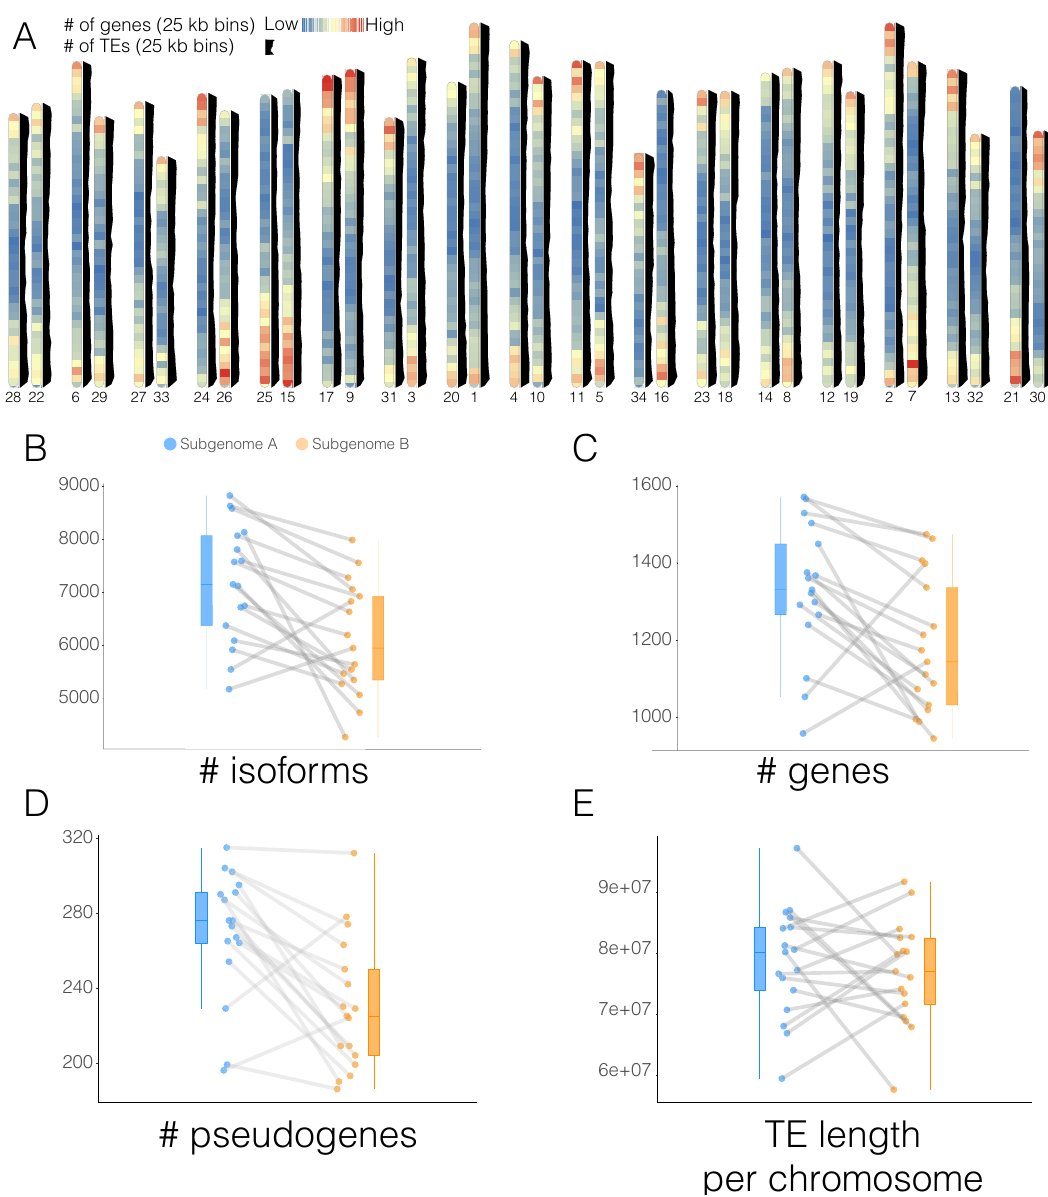
Fig. 3 Subgenome evolution and characterisation. A Ideogram with gene and transposable element distribution in 25-kbp bins. Gene density is plotted in chromosome representations and transposable element distribution is plotted to the side of each chromosome in black. Chromosomes are arranged in homoelogous pairs. B The number of isoforms detected for each subgenome. Each data point corresponds to a chromosome in a subgenome (subgenome A in blue and B in orange; 17 pairwise comparisons; subgenome A: min = 5176; max = 8817, avg = 7175; Subgenome B: min = 4277; max = 7982, avg = 6103). Chromosome pairs are linked by grey lines. C Number of genes detected for each subgenome (17 pairwise comparisons; subgenome A: min = 1571; max = 1571, avg = 1327; Subgenome B: min = 944; max = 1474, avg = 1181). D The number of pseudogenes detected for each subgenome (17 pairwise comparisons; Subgenome A: min = 196; max = 315, avg = 270; subgenome B: min = 186; max = 312, avg = 230). E Length of transposable elements detected for each subgenome (17 pairwise comparisons; subgenome A: min = 59,440,194; max = 97,142,619, avg = 78,545,717; Subgenome B: min = 57,631,669; max = 91,646,014, avg =